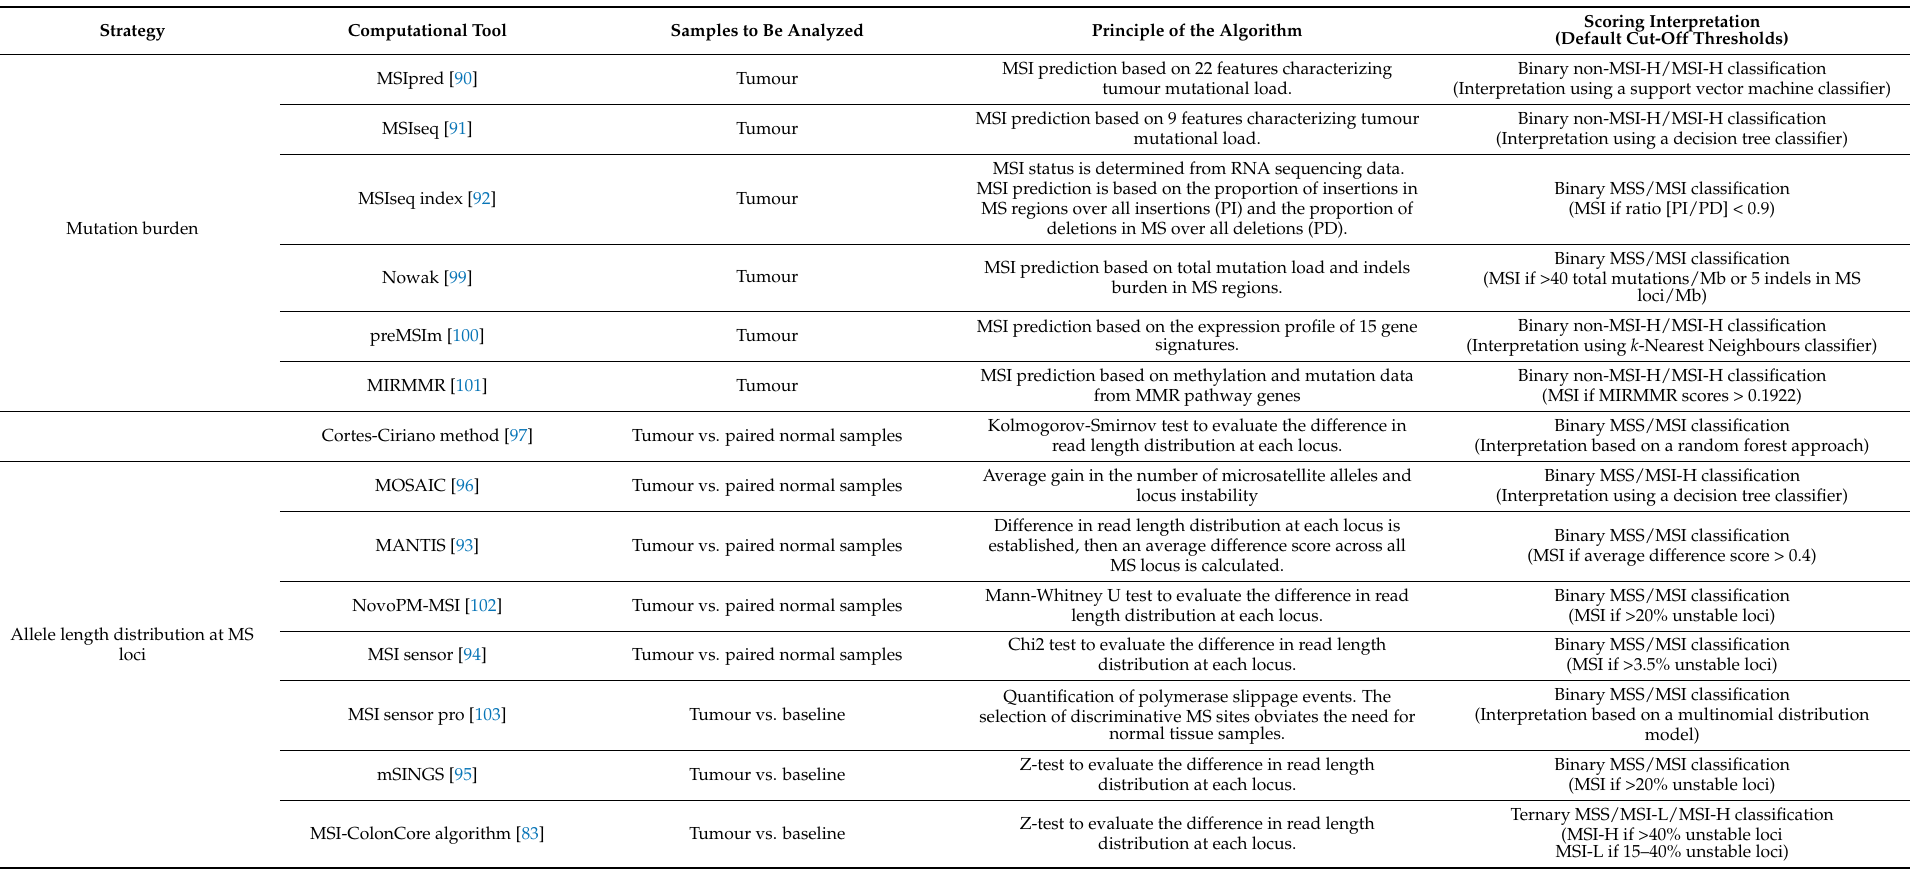
Table 3. Examples of NGS-based computational tools for MSI